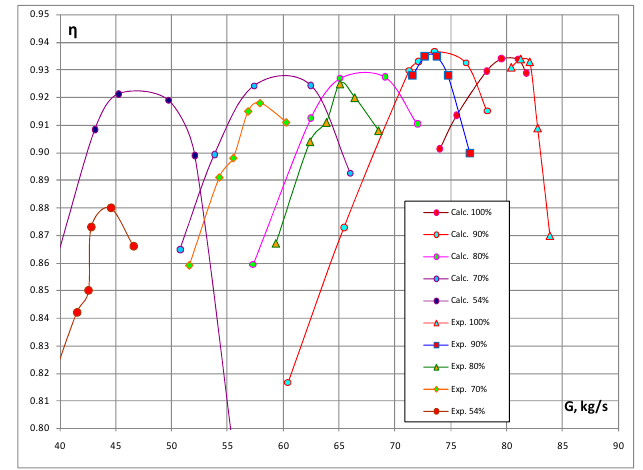
Figure 37. Fan efficiency map.